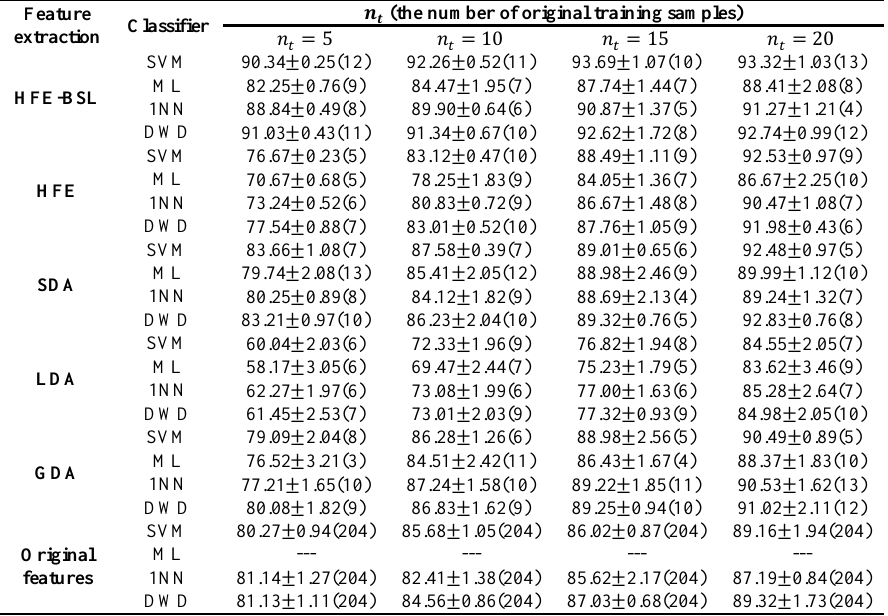
Table 9. Highest average classification accuracies and their corresponding standard deviations for Salinas dataset. Number in parenthesis represents number of features achieving highest accuracies in